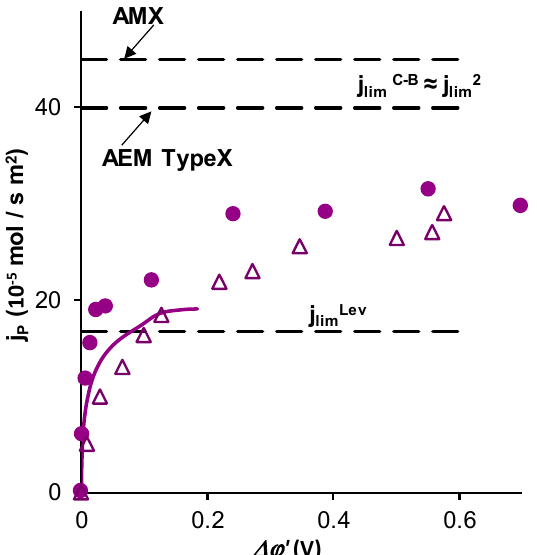
Figure 4. Experimental (markers) and calculated using the model [31,32] (solid line) total phosphorus flux density through the AMX (circles) and AEM Type-X (triangles) membrane vs. the reduced potential drop. Here j limLev = i limLev / F , where i limLev is calculated using Equation (6); j limC-B = i limC-B / F , where i limC-B is found from the CVC curves by the Cowan–Brown method [43].